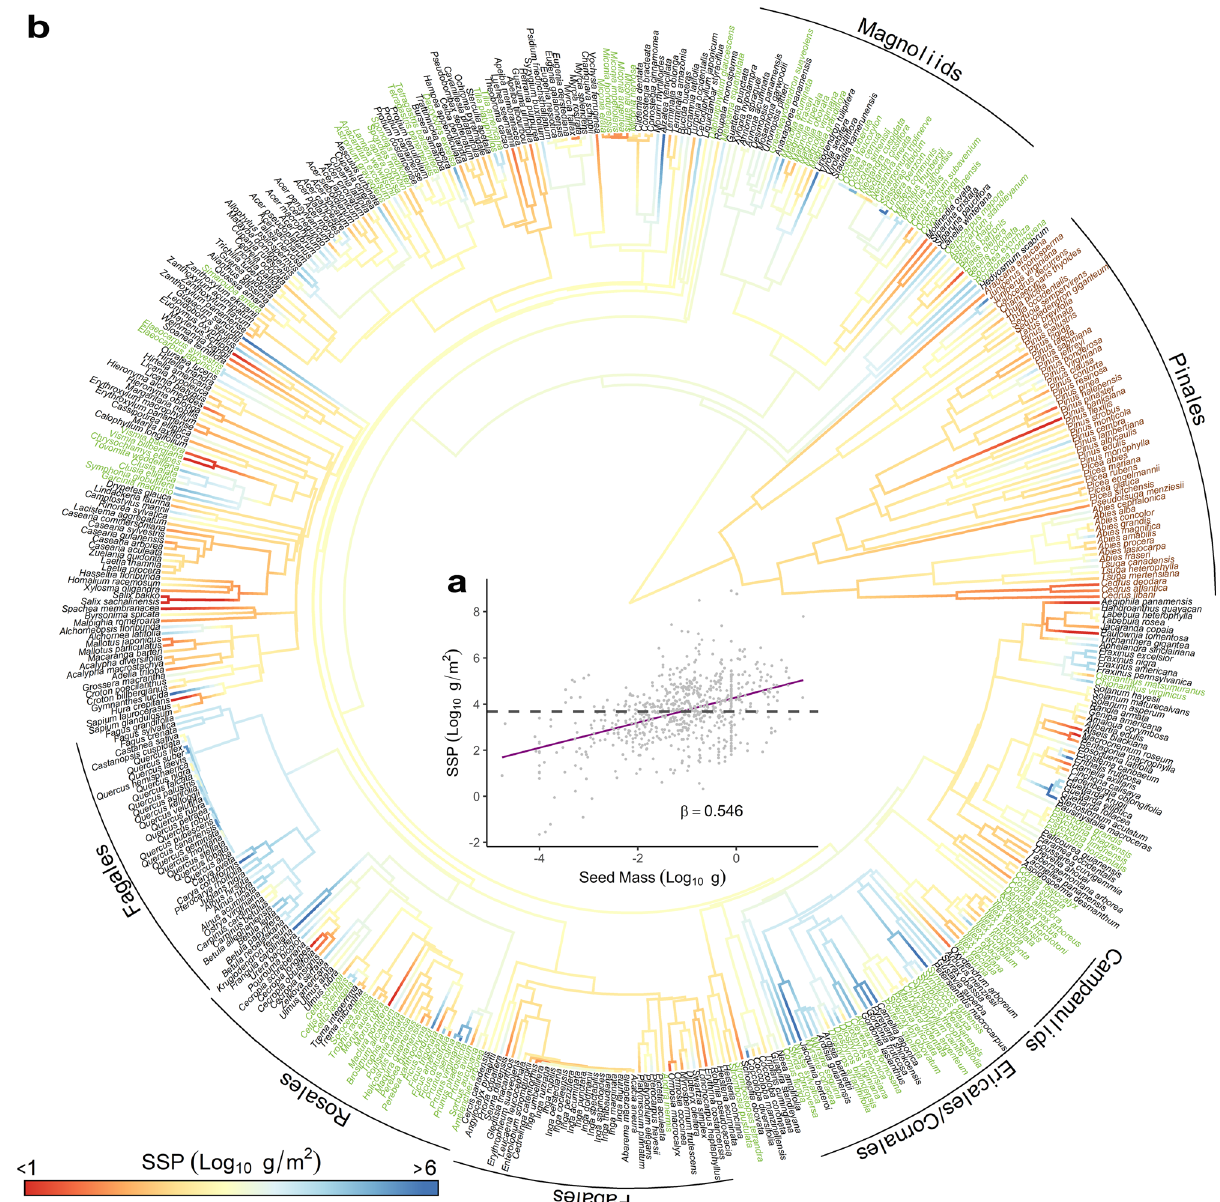
Fig. 2 seed size-number trade-offs and species seed production. a Species seed production (SSP, g seed per m 2 tree basal area) is not constrained by the strict size-number trade-off (dashed line with a slope of zero). Instead, it varies over ten orders of magnitude and has a positive correlation with seed mass across 714 tree species (log 10 SSP ¼ 4 : 29 þ 0 : 546 (cid:3) log 10 m , R 2 = 0.189, p < 10 − 15 , n = 714). b SSP exhibits phylogenetic coherence for 482 species having phylogeny data (68% of species). Brown and green text highlight species that produce coniferous cones and fl eshy fruits, respectively. The phylogenetic signal is estimated using Pagel 's λ = 0.60 ( p < 10 − 9 , n =